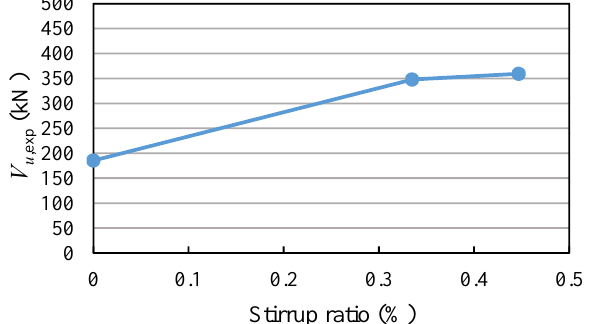
Figure 11. Relationship of shear capacity and stirrup ratio.